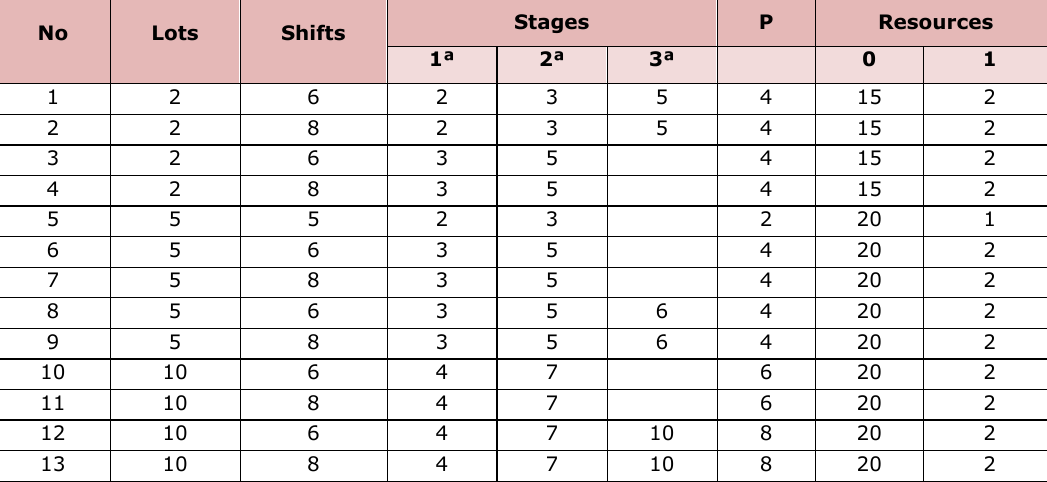
Table 2. “Considered factors to obtain the instances”. Source: